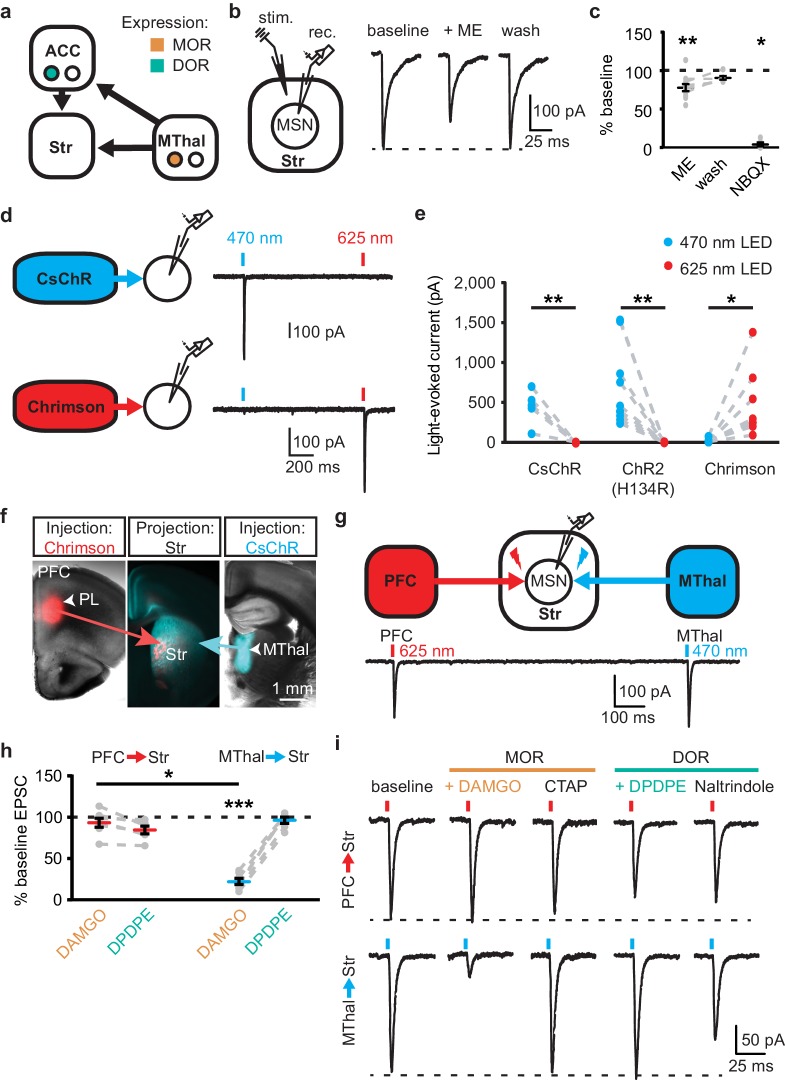
Mu-opioid agonists suppress thalamic, but not cortical inputs.(a) Schematic of thalamo-cortico-striatal circuits and putative expression pattern of MORs (orange) and DORs (teal) (Erbs et al., 2015; Hunnicutt et al., 2016). (b) Schematic and example traces of electrically-evoked EPSCs from an MSN in the DMS. ME: non-selective opioid agonist [Met5]-enkephalin (3 µM). (c) Summary data of opioid inhibition of EPSCs, as shown in (b), plotted as a percent of peak current in the drug condition relative to the baseline. ME: N = 6, n = 11; wash: N = 3, n = 6, SM = 9.712, p<0.01; baseline vs. ME: W(11) = 1, p<0.01; baseline vs. wash: W(6) = 1, p=0.063; NBQX: N = 4, n = 5; baseline vs. NBQX: W(5) = 0, p<0.05. (d) Independent activation of CsChR and Chrimson using two-wavelength optical excitation. CsChR (blue): virus expressing CsChR injected into the MThal; Chrimson (red): virus expressing Chrimson injected into the ACC. Blue bars: optical excitation with 470 nm light (1 ms, 0.5 mW); red bars: 625 nm light (3 ms, 1.4 mW). (e) Quantification of spectral selectivity of CsChR, ChR2(H134R), and Chrimson plotted as peak optically-evoked EPSC (oEPSC) amplitude following 470 nm (blue) or 625 nm (red) LED optical excitation (CsChR: N = 2, n = 5, I625nm:I470nm = -0.0002 ±. 0081, paired t-test p<0.01; ChR2 (H134R): N = 4, n = 10, I625nm:I470nm = 0.0009 ±. 002, paired t-test p<0.01: Chrimson: N = 5, n = 8, I470nm:I625nm = 0.0423 ± 0.014, paired t-test p<0.05). (f) Overlaid brightfield and epifluorescent images of coronal brain slices showing expression of CsChR in the MThal and axonal projections to the DMS (blue), and expression of Chrimson (red) in the PFC and axonal projections to the DMS (red). (g) Two-wavelength optical excitation elicited EPSCs in response to 470 and 625 nm light in single MSNs when CsChR was injected into the MThal and Chrimson was injected into the PFC. (h) Summary data of DAMGO (1 µM, orange) and DPDPE (1 µM, teal) effects on oEPSCs elicited from the MThal (blue) and PFC (red) using two-wavelength optical excitation protocol. Linear mixed model: 3-way interaction; opioid type (mu vs. delta opioid) x source (PFC vs. MThal) x condition (baseline vs. agonist vs. antagonist): F(4,7) = 2.171, p=0.174, N = 5, n = 7; DAMGO: IMThal; 22.2 ± - 3.6% of baseline, z = 3.497, p<0.001, IPFC; 93.9 ± 5.6%, z = 0.052, p=0.958; DPDPE: IMThal; 96.4 ± 3.9% of baseline, z = 0.087, p=0.931; IPFC: 81.6 ± 3.9%, z = 0.672, p=0.502. MThalbaseline x DAMGO vs. ACCbaseline x DAMGO; z = −2.436, p<0.05. (i) Example traces for summary data shown in (h). *p≤0.05; **p≤0.01; ***p≤0.001. Mean ± standard error of the mean. N: number of animals; n: number of recorded cells; Str: striatum; PL: prelimbic cortex.